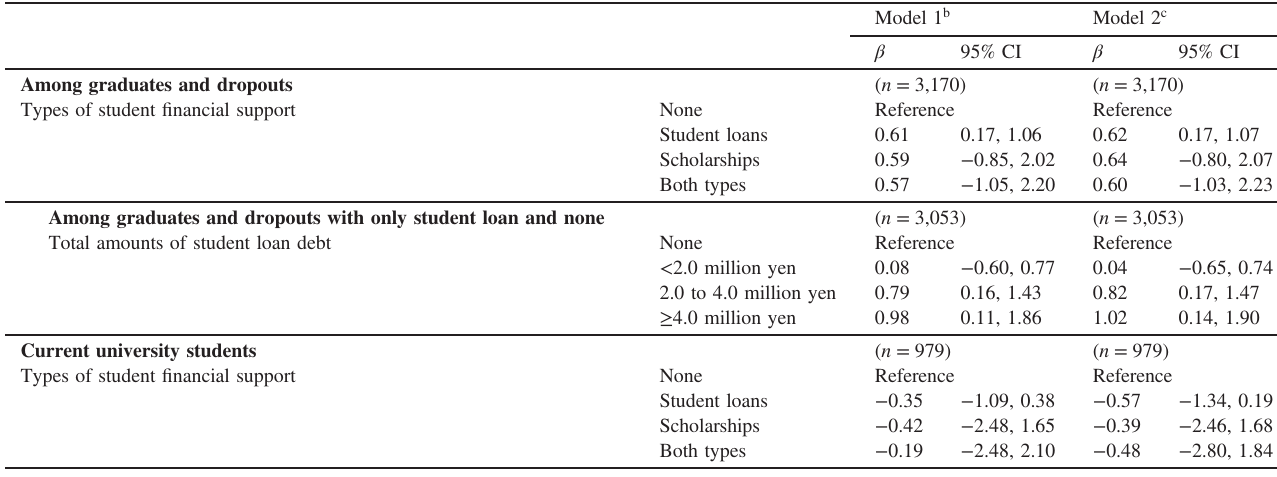
Table 4. Associations of the types of student fi nancial support and the total amount of student loan debt with psychological distress a from linear regression models strati fi ed by current student status after